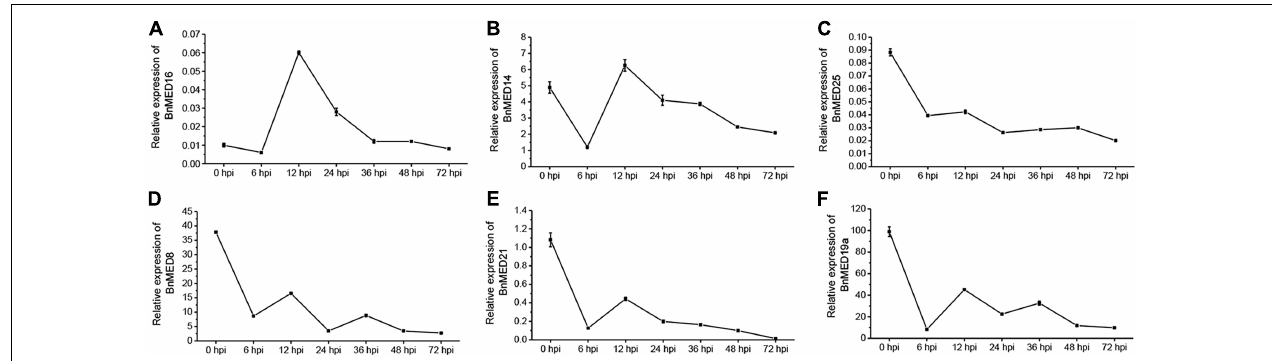
FIGURE 1 | Expression pattern of mediator subunits in Brassica napus leaves with the treatment of Sclerotinia sclerotiorum at different time points after inoculation. RT-QPCR analyses of MED16 ( BnaA09g20140D ) (A) , MED14 ( BnaAnng10600D ) (B) , MED25 ( BnaA09g28640D ) (C) , MED8 ( BnaA09g53670D ) (D) , MED21 ( BnaA09g20250D ) (E) , and MED19a ( BnaC09g44480D ) (F) in leaves at seedling stage of wild-type (WT, Westar) inoculated with S. sclerotiorum . BnACTIN7 was used as the internal control; data are means ± SD of three biological replicates; hpi, hours post-inoculation.